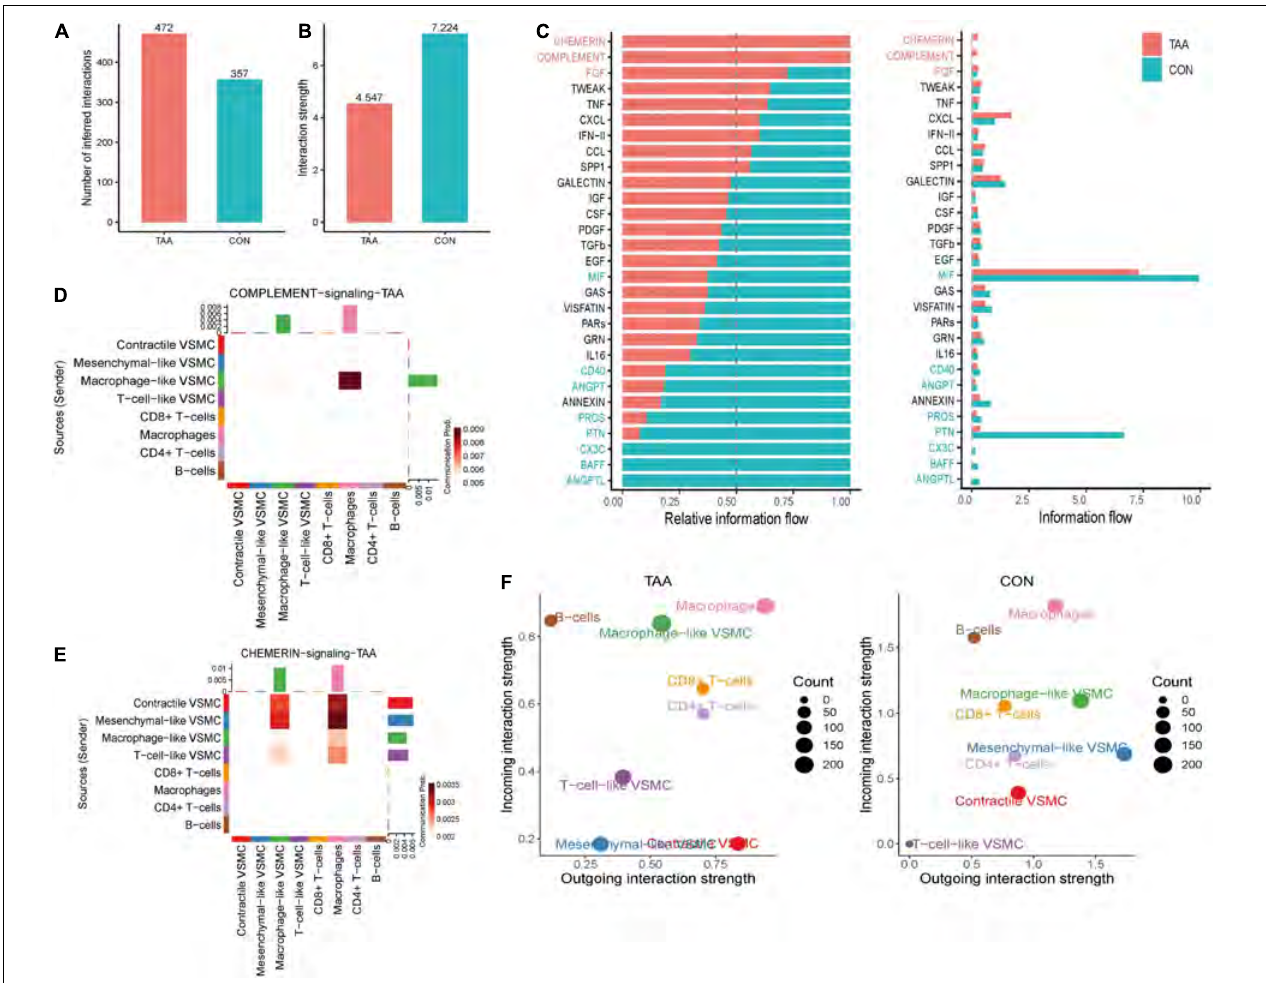
FIGURE 6 | Alterations of intercellular communication patterns between the aortic aneurysm and normal aorta. The number of interactions increased (A) , but the mean interaction strength decreased in aortic aneurysms (B) . Relative information flow of the significant signaling pathway in the normal aorta and aortic aneurysm (C) . Sources and targets of signaling complement (D) and chemerin (E) . Alteration of incoming/outgoing communication ability of each cell type between the aortic aneurysm and normal aorta (F)